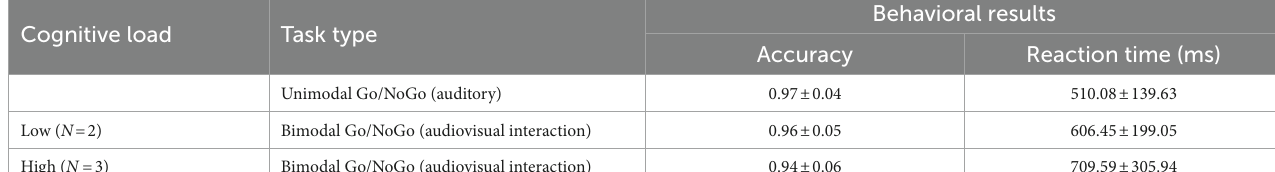
TABLE 2 Behavioral performance on the unimodal Go/NoGo task (auditory) and bimodal Go/NoGo task (audiovisual interaction; mean ± standard deviation).